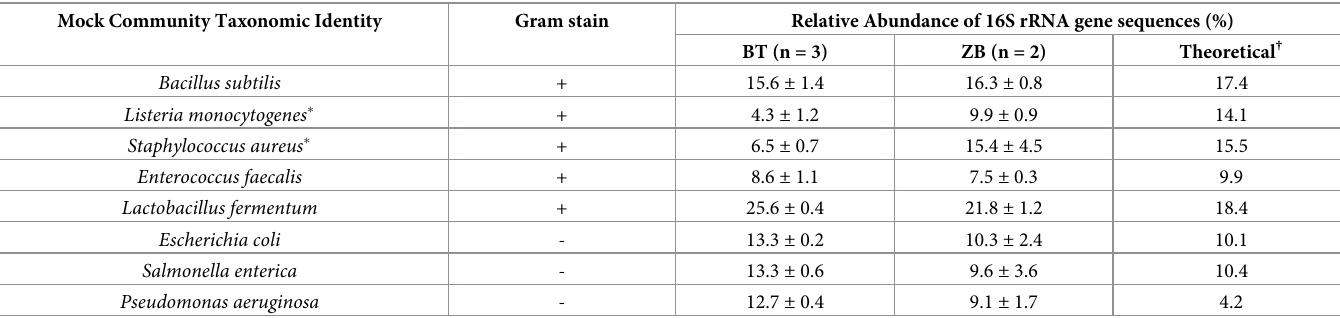
Table 2. Efficiency of mock community extraction.